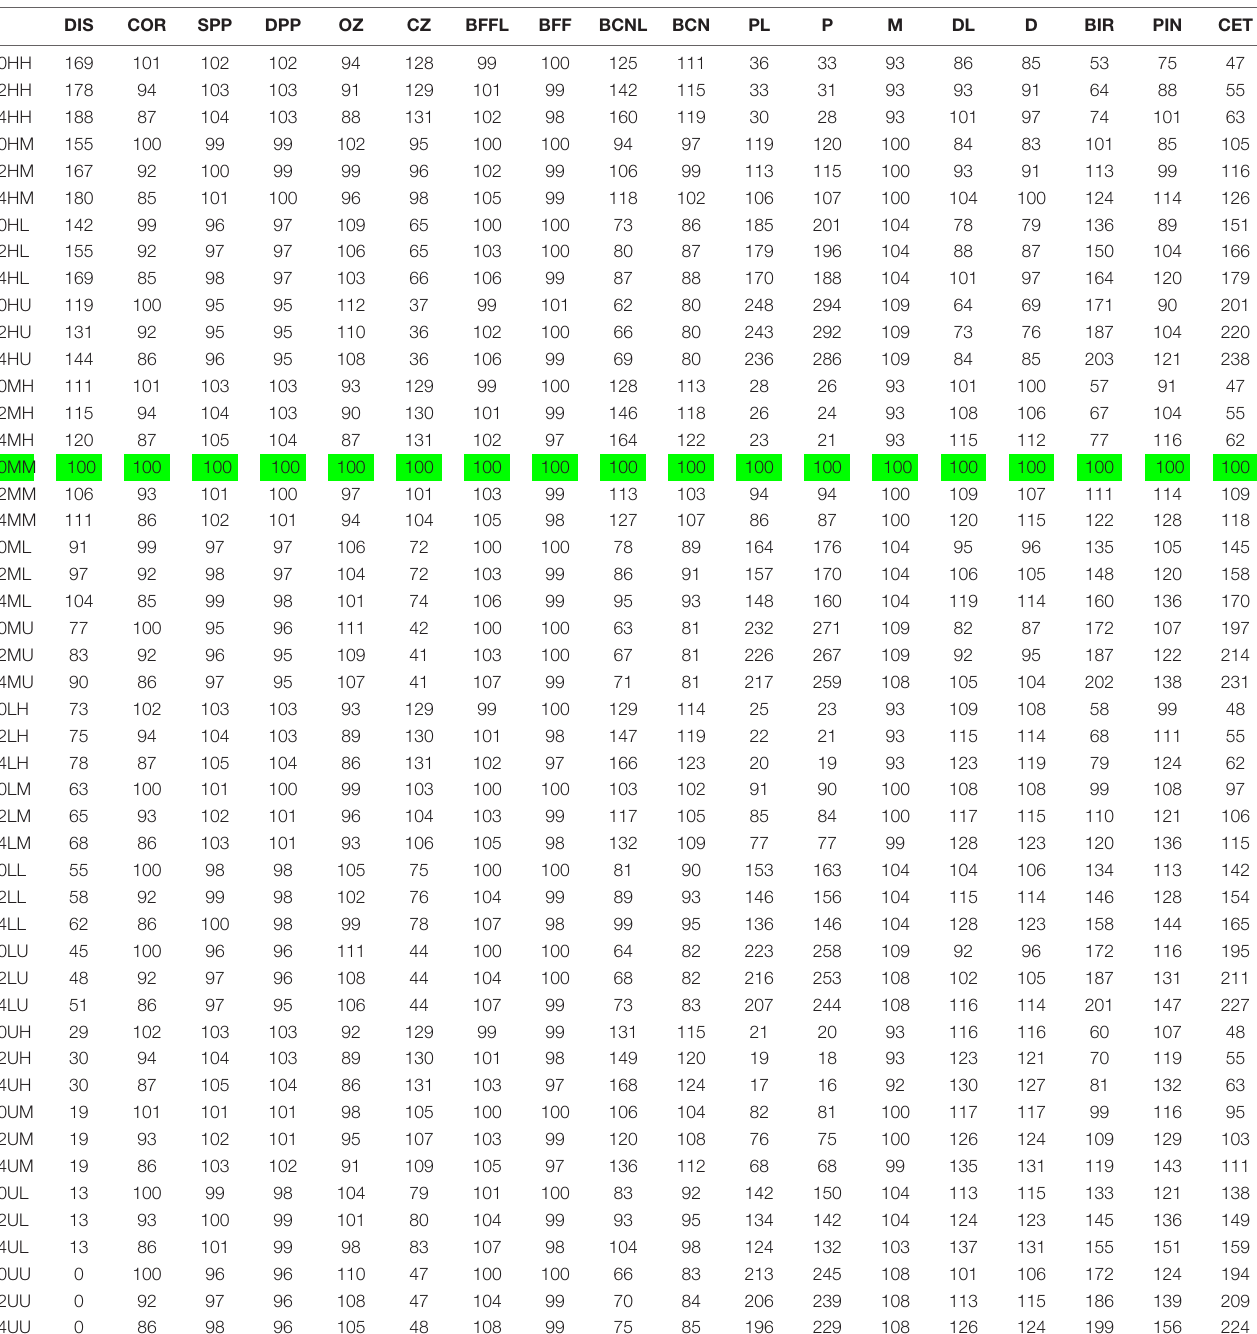
TABLE 1 | Biomasses of the 18 functional groups for each experimental